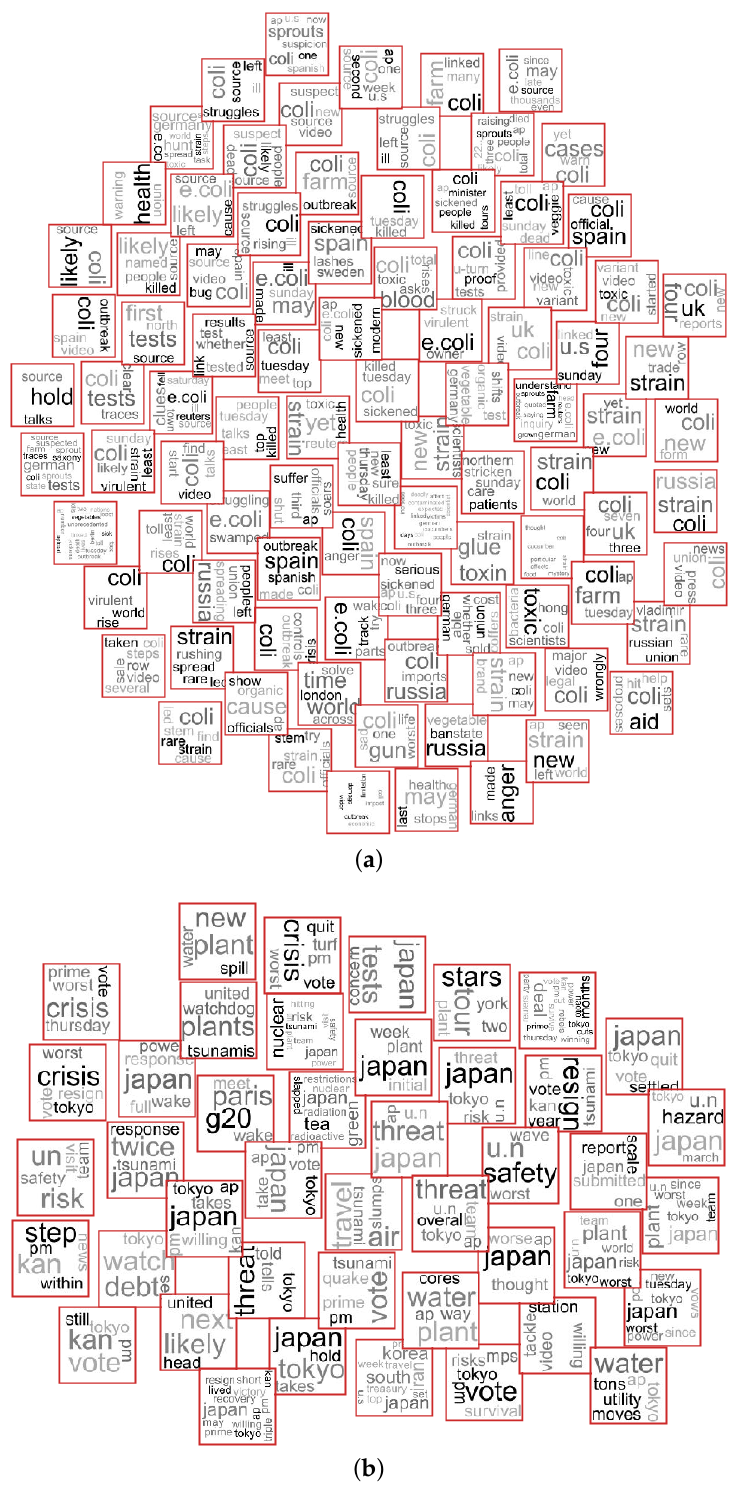
Figure 10. Analysis of the NEWS-8 dataset: ( a ) zoom in of Selection A from Figure 9 and ( b ) zoom in of Selection B from Figure